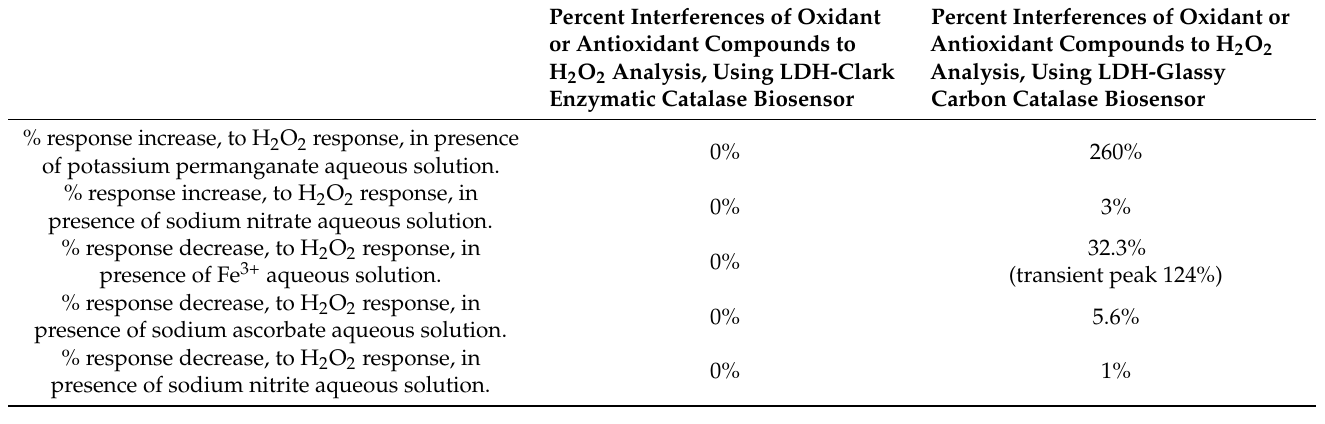
Table 2. Inferences in hydrogen peroxide determination using the fabricated Clark-type LDH-catalase enzyme biosensor (this work) and the previously developed GC–LDH-catalase biosensor (Ref. [29]). Each added interfering species had a final concentration in solution equal to that of hydrogen peroxide.